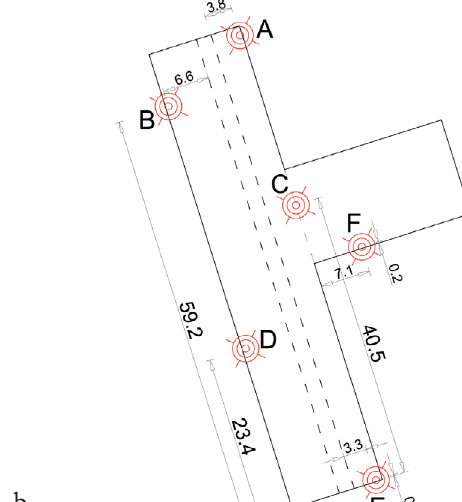
Figure 9. (a) Satellite image and (b) simplified building floor plan of KSUCTA (Figure 2,VI), showing the locations of the installed stations (red symbols).